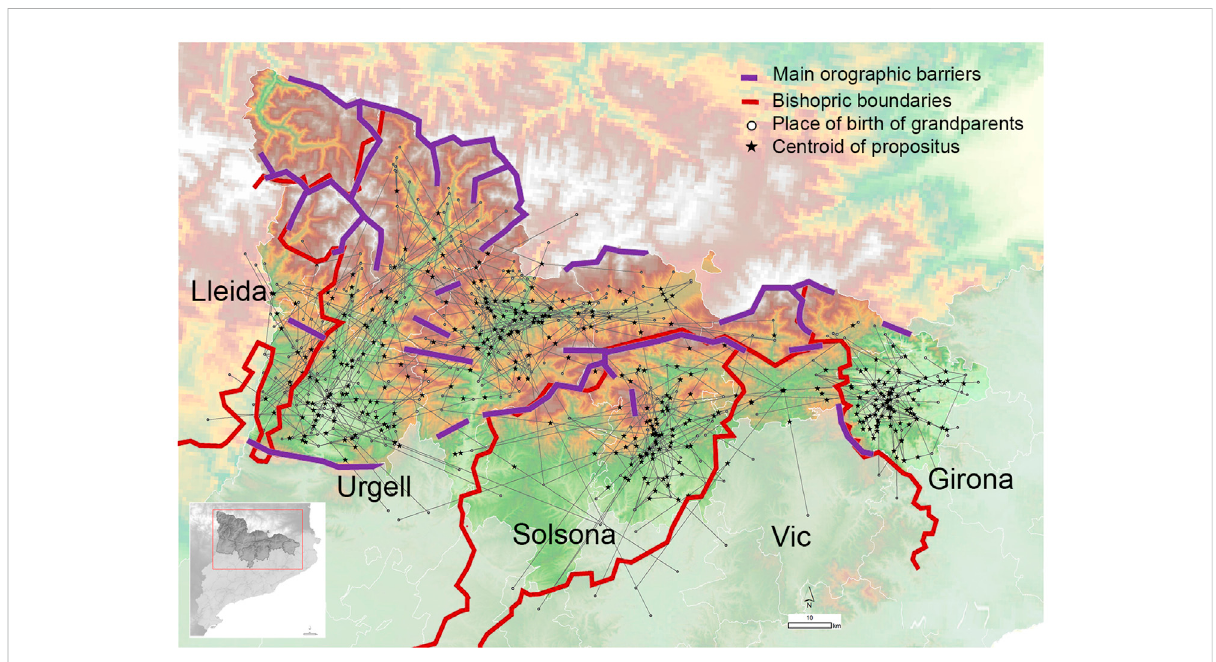
FIGURE 8 Geographic location of the individuals with regards to the mating relationship of grandparents. Each propositus is linked to their grandparents generating a complex network centered on bishoprics. Red lines delimit the bishopric boundaries. Purple lines indicate the presence of orographic events preventing direct routes of contact between